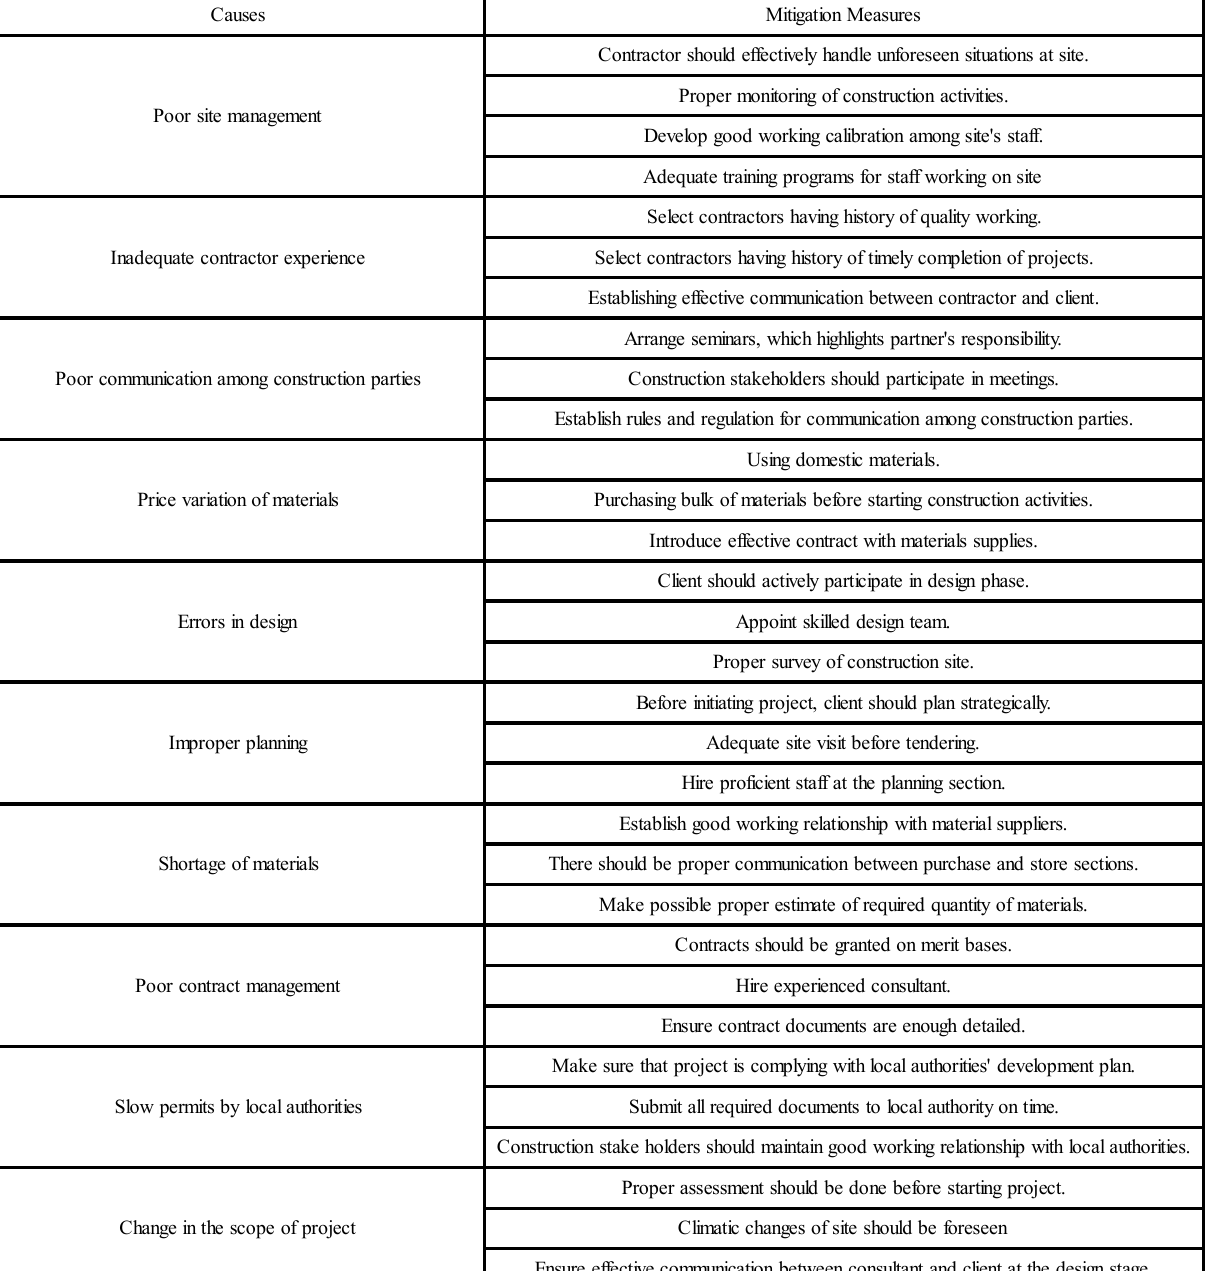
TABLE 6. MITIGATION MEASURES FOR TOP CAUSES OF CONSTRUCTION